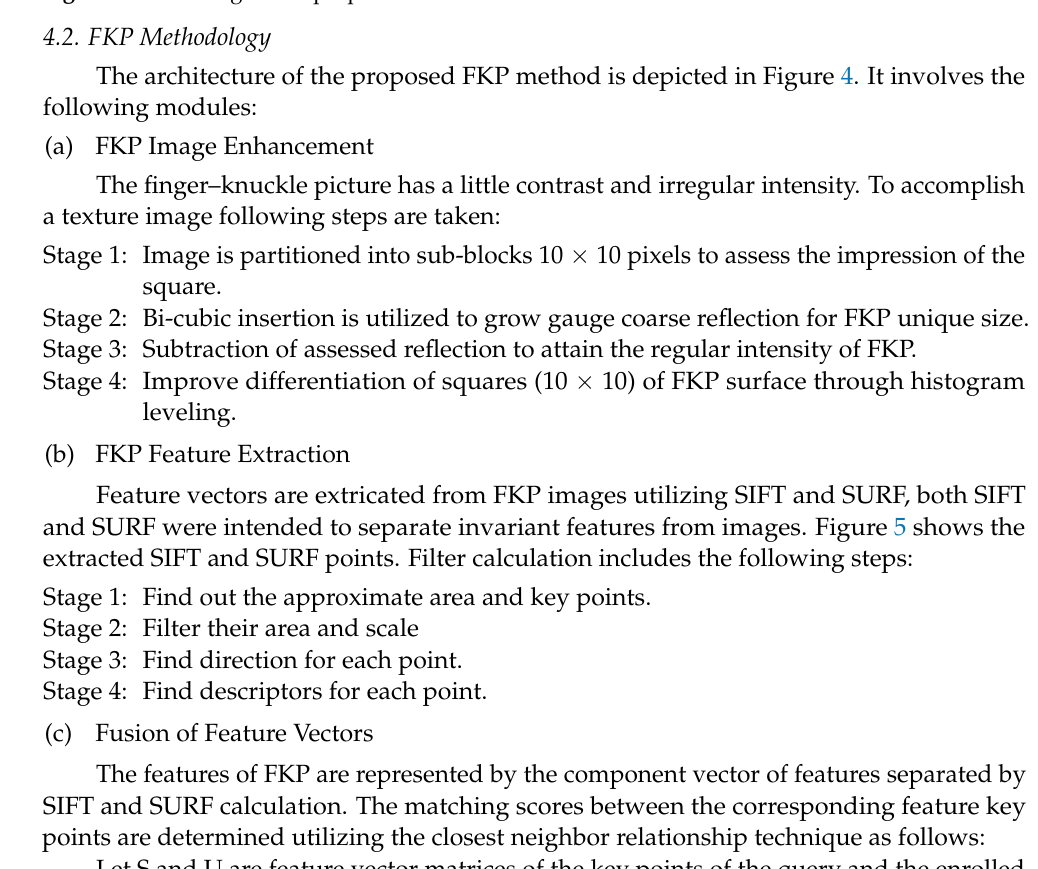
Figure 3. Block diagram of proposed model.